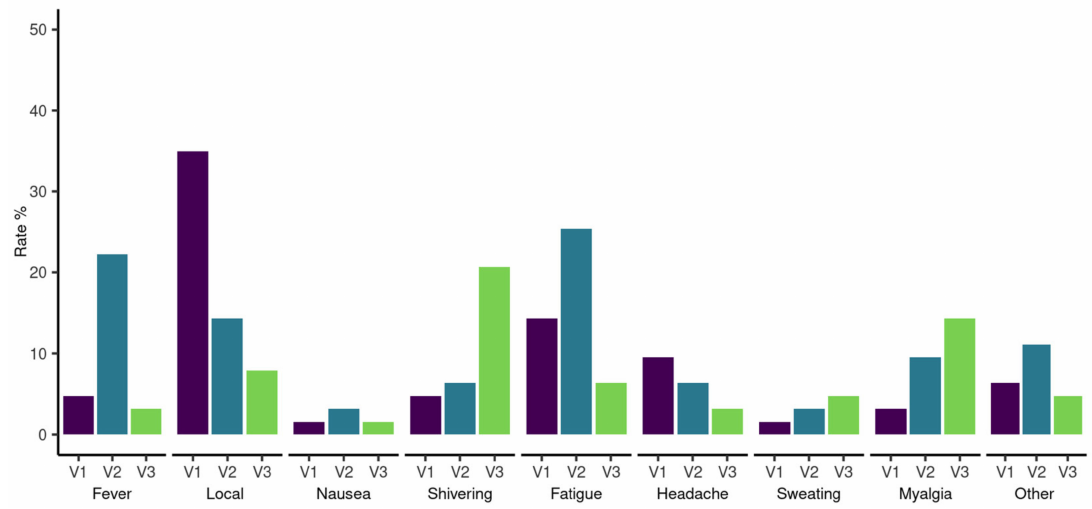
Figure 6. Proportion of adverse events for hematological patients after SARS-CoV-2 vaccination. The proportions are ordered by adverse event and first (V1), second (V2), and third (V3)